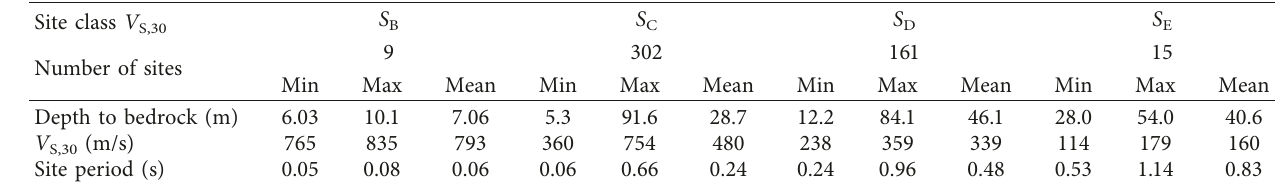
Figure 2: 109 shear-wave velocity profiles 378 soil strata from Lee et al. [11]. Site class: (a) S Table 1: Summary of the soil properties of 487